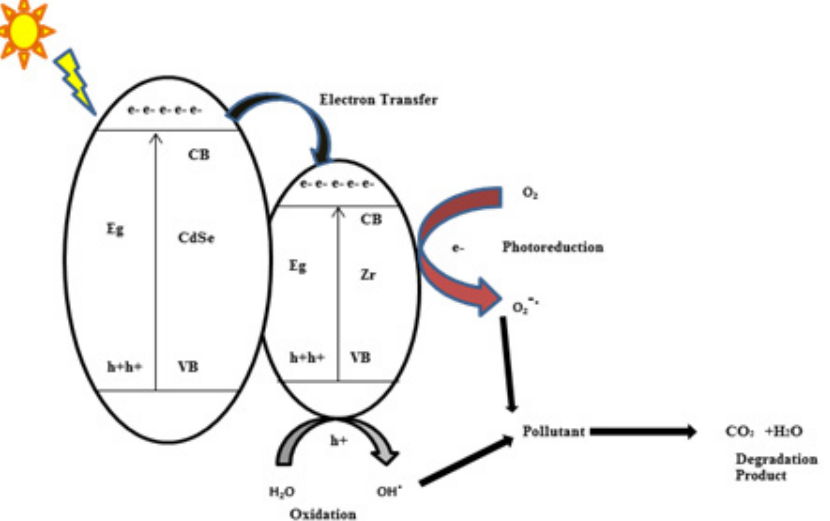
Fig. 9. Mechanism for the photodegradation of IC dye on Ze-CdSe